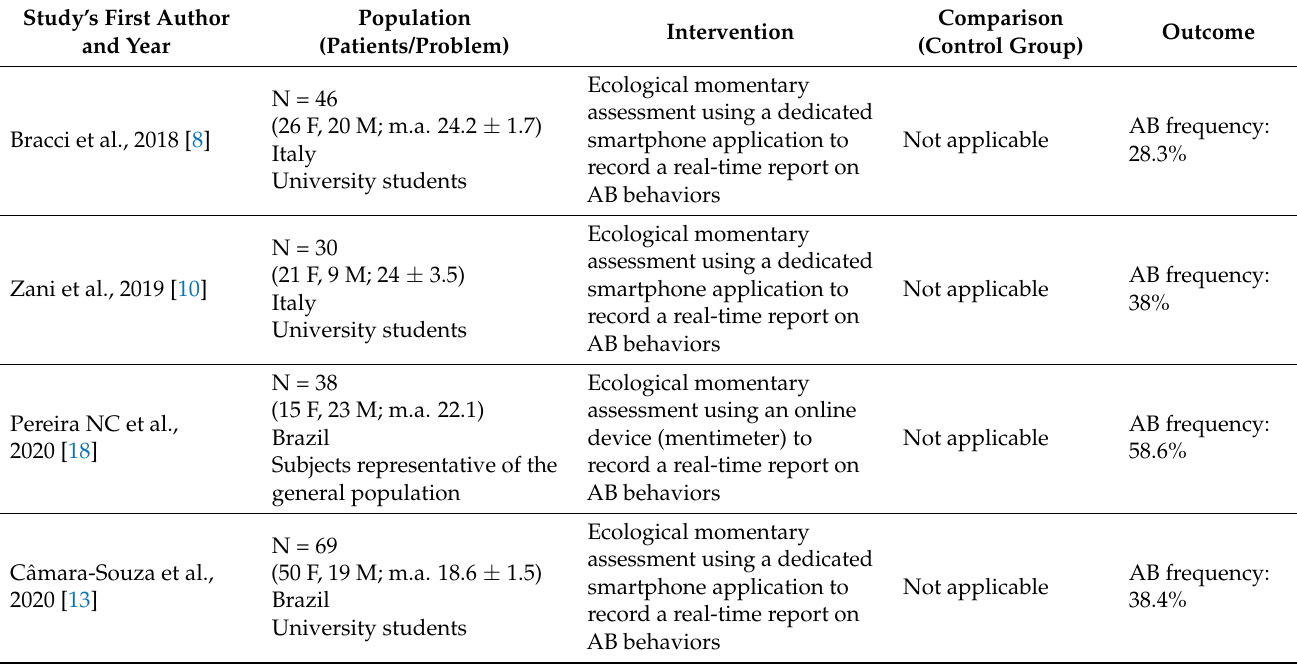
Table 1. Summary of the findings from studies included in the final review. PICO